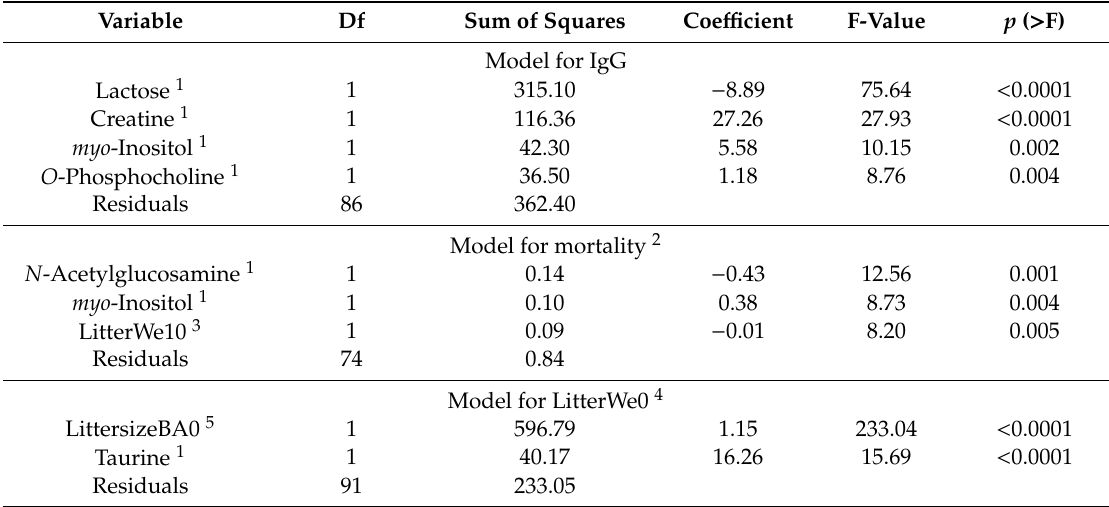
Table 7. Results of ANOVA analyses on Brix percentage estimate of colostrum immunoglobulin G concentration and sows’ productive traits.